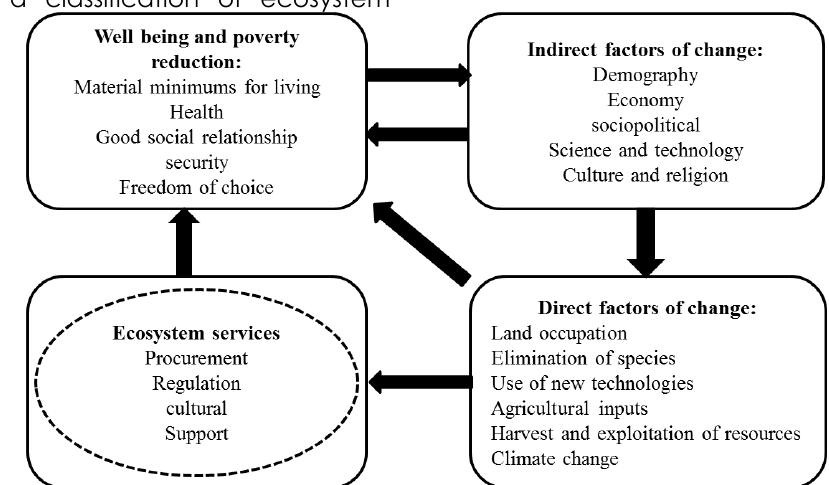
Fig 2. Framework for Ecosystem Services Analysis (Roche et al,